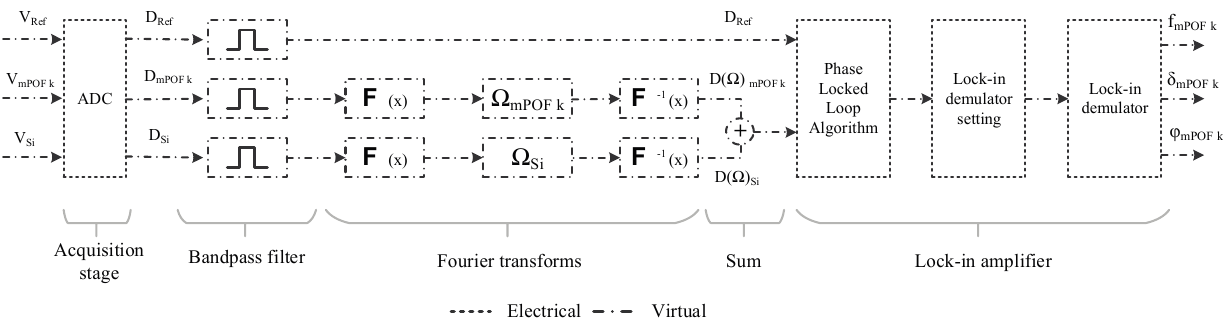
Figure 3. Block diagram of the computer software used to acquire and process the electrical